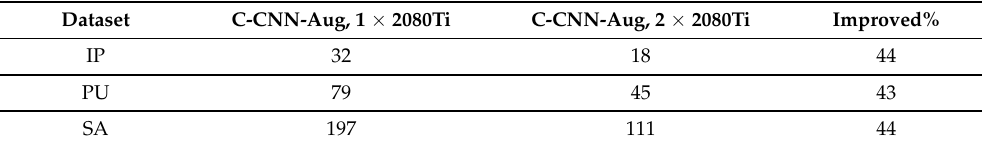
Table 7. The processing time comparison by 1 and 2 GPUs on benchmark datasets (Measured unit: